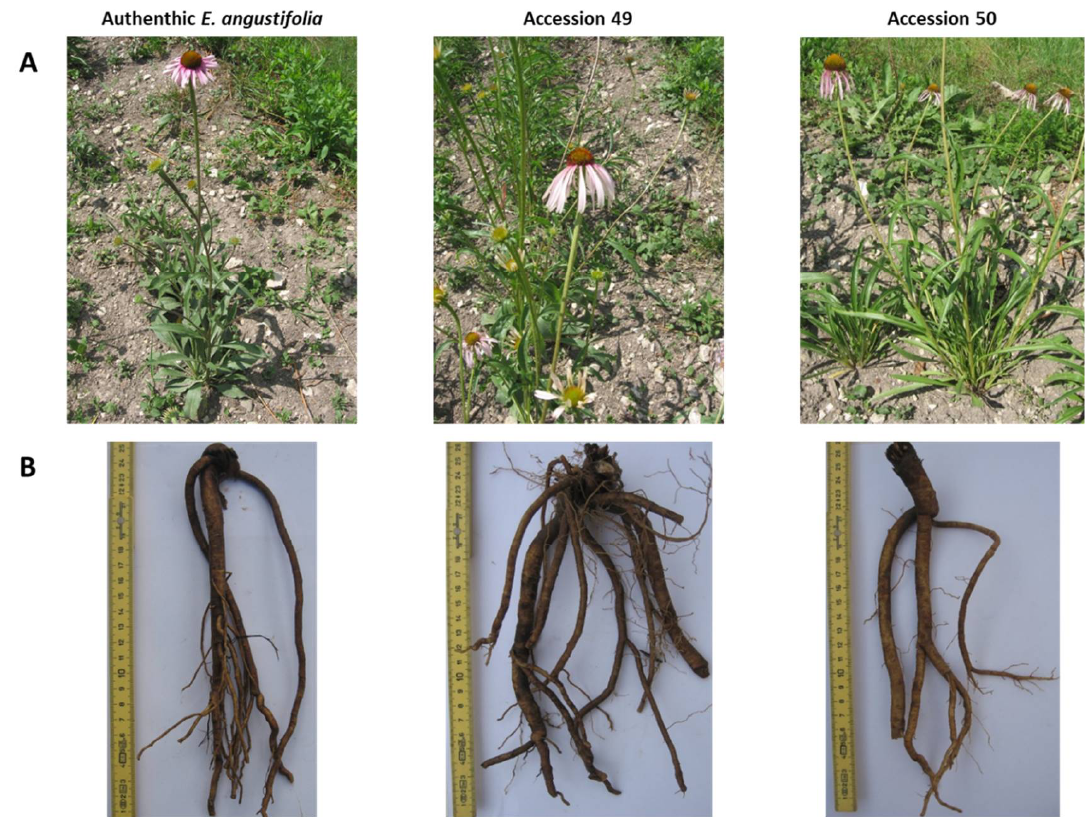
Figure 3. Morphological traits of an authentic E. angustifolia and of accessions 49 and 50. ( A ): aerial parts, ( B ): roots.